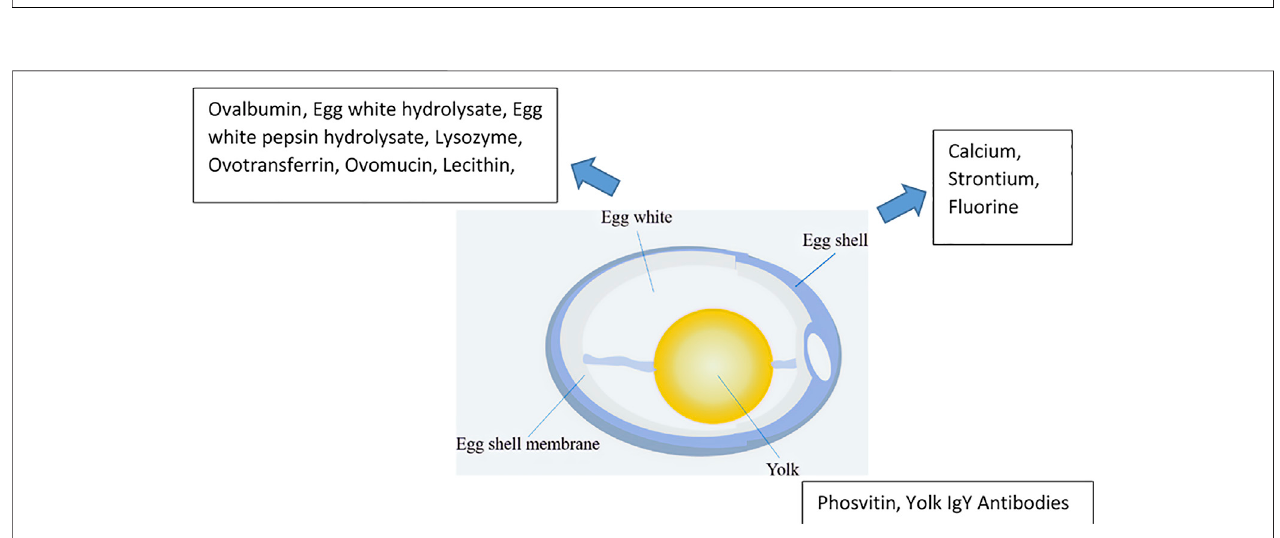
FIGURE 2 | Structure of a hen ’ s egg